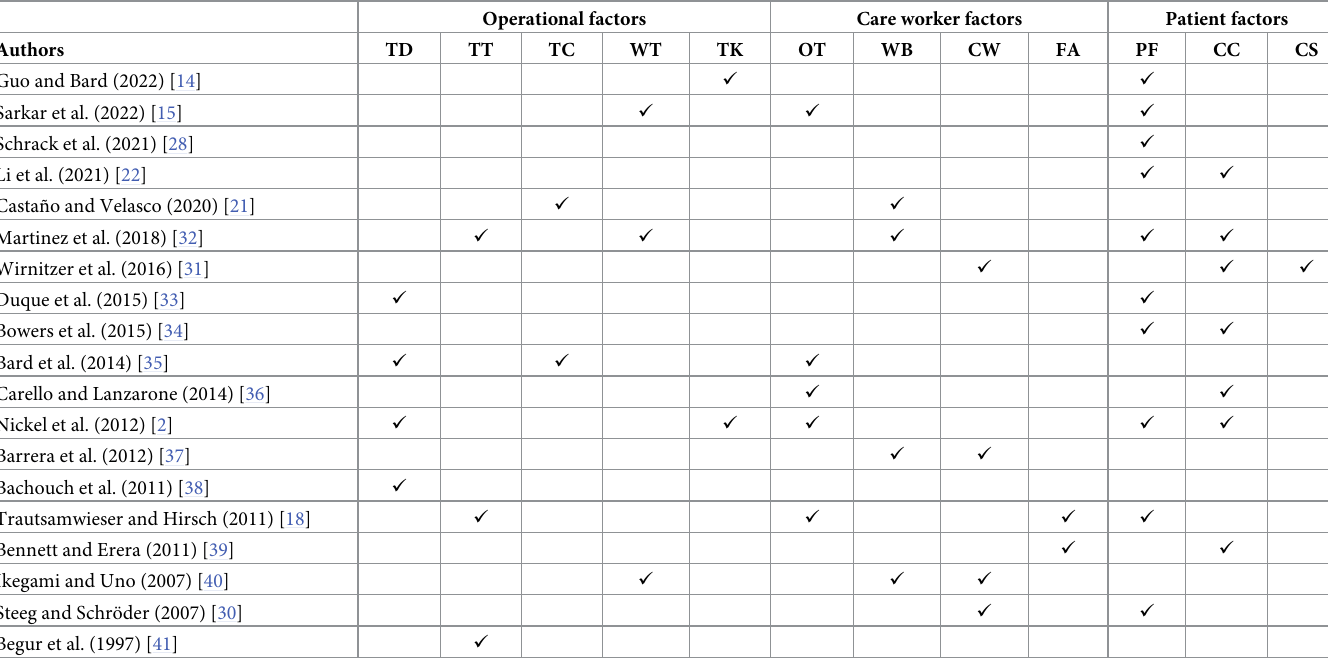
Table 1. Summary of the existing objective functions for multi-period